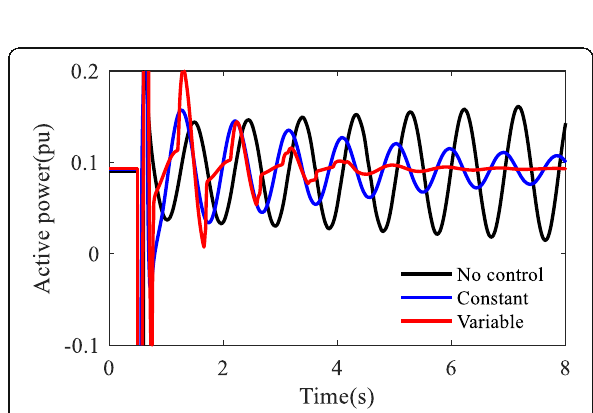
Fig. 15 The active power output of the PV-VSG when the output power of the PV is 0.09 pu